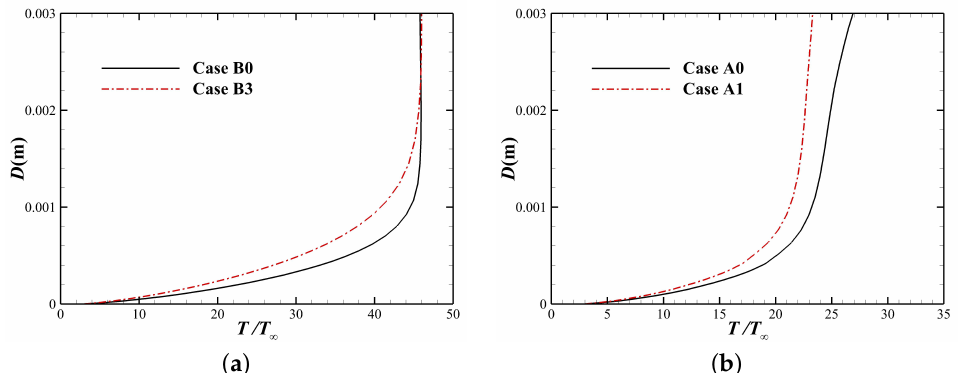
Figure 14. Temperature boundary layer profiles at stagnation point: ( a ) Perfect gas. ( b ) Chemical nonequilibrium.